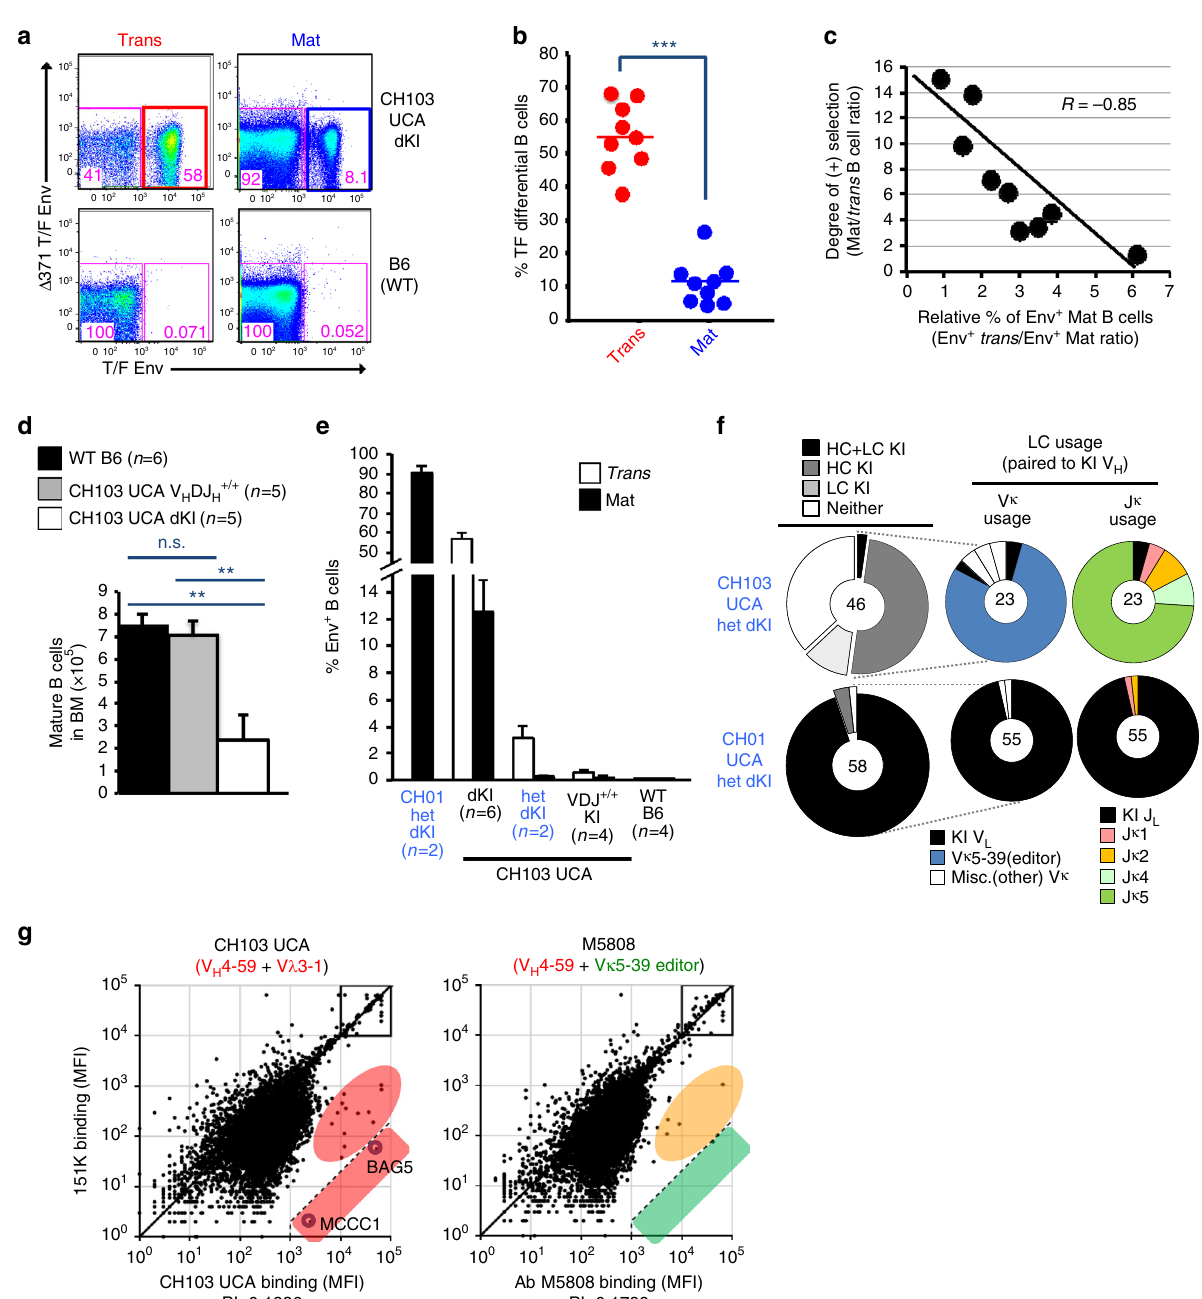
Fig. 5 Analysis of receptor editing in CH103 germ line knock-in mice. a – c Env reactivity in mature B cell compartments of CH103 unmutated